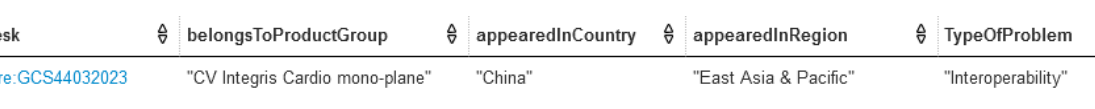
Figure 14. Example information extracted from customer call logs.